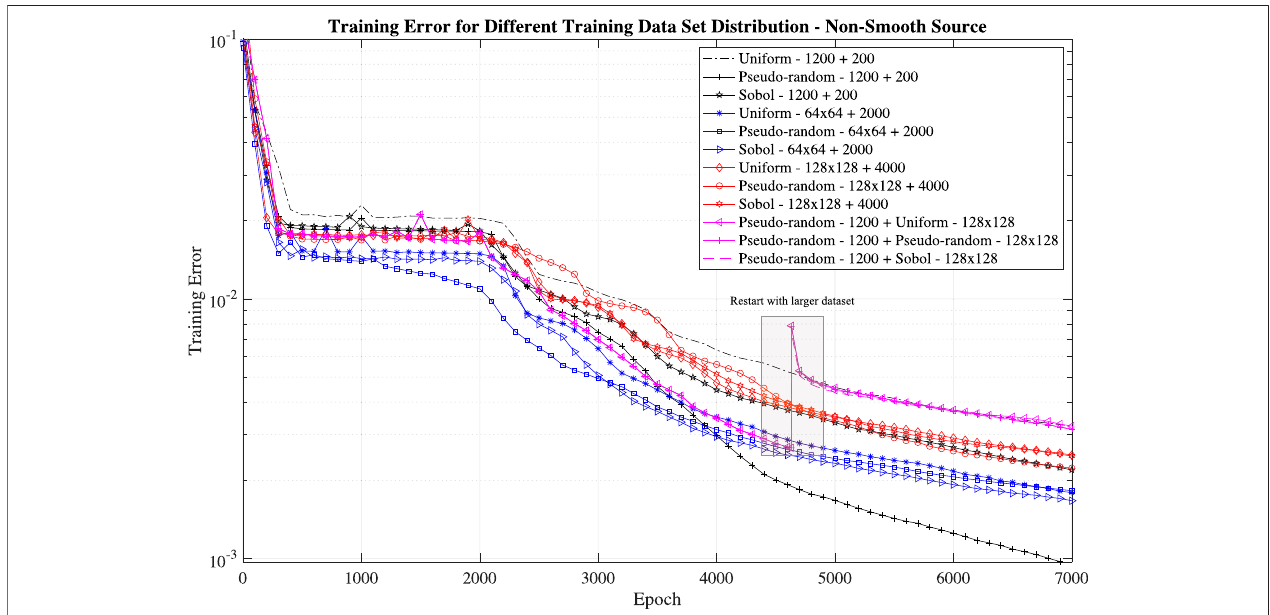
FIGURE 5 | Training error for different data set (1,200 points in the domain and 200 on the boundary, 64 × 64 points in the domain and 2,000 on the boundary, 128 × 128 points in the domain and 4,000 on the boundary) and different distribution (uniform, pseudo-random and Sobol).